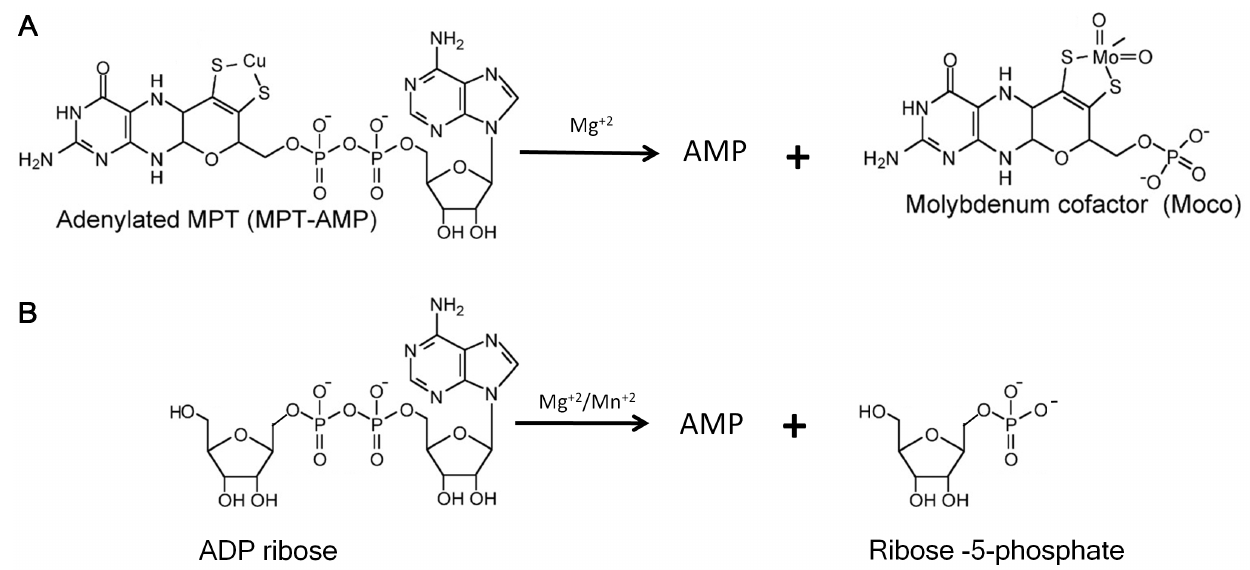
Figure 2. Pyrophosphatase reactions catalyzed by bacterial MoeA and its eukaryotic ortholog (A) and ADP-ribose pyrophosphatase (B). Both substrates share an adenosine group linked to two different moieties through the pyrophosphate bridge which is cleaved during the enzyme-catalyzed reaction.